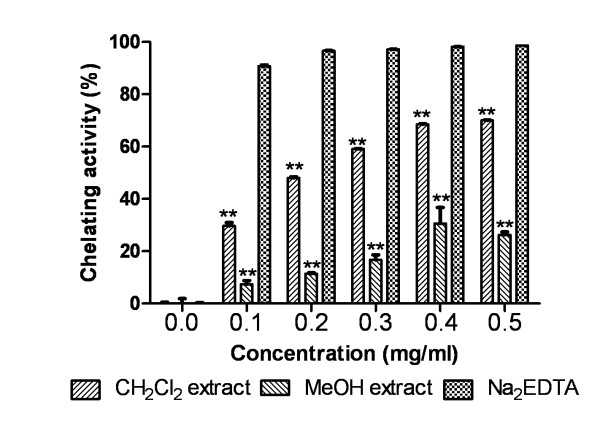
Metal chelating activity. Effect of Dragon's blood resin extracts and standard Na2EDTA on metal chelating assay. The percentage of chelation was plotted against concentration of sample. **P < 0.0001 vs 0 μg/ml.